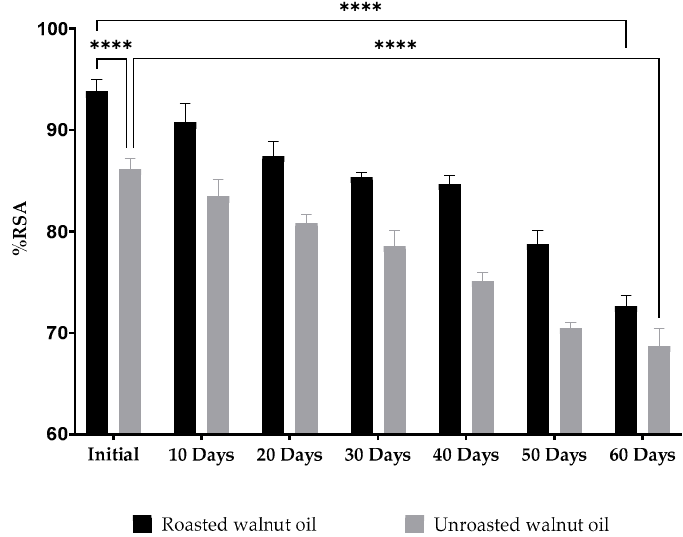
Figure 2. The evolution of the radical scavenging activity (RSA) during 60 days. **** ( p <